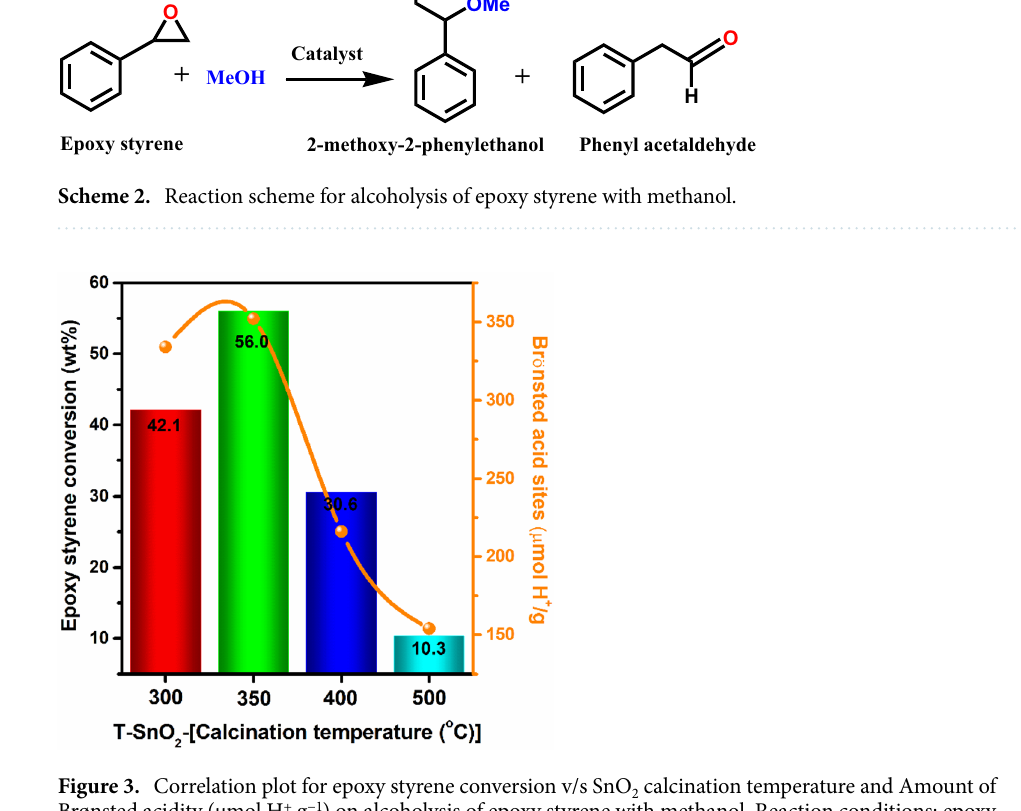
Figure 3. Correlation plot for epoxy styrene conversion v/s SnO 2 calcination temperature and Amount of Brønsted acidity (μmol H + g −1 ) on alcoholysis of epoxy styrene with methanol. Reaction conditions: epoxy styrene = 2 g, methanol = 5.3 g (mole ratio = 1:10), catalyst = 0.1 g, reaction temp = 65 °C, time = 30